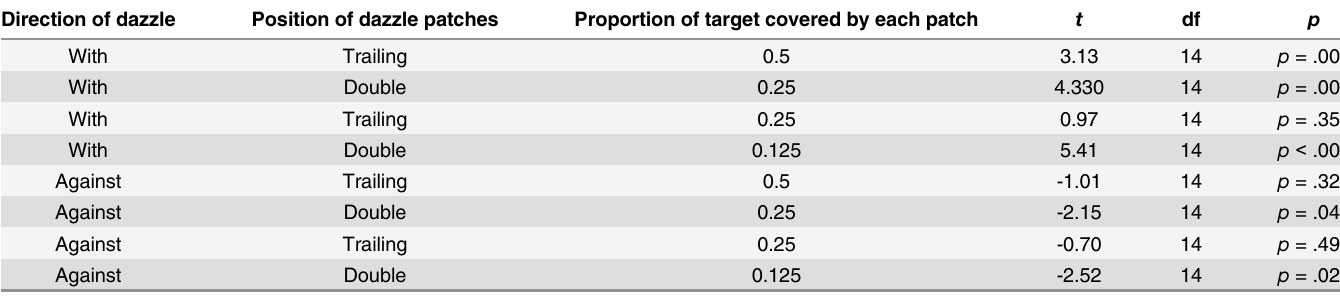
Table 3. One-sample t -test results for different combinations of dazzle size and number of patches. Direction of